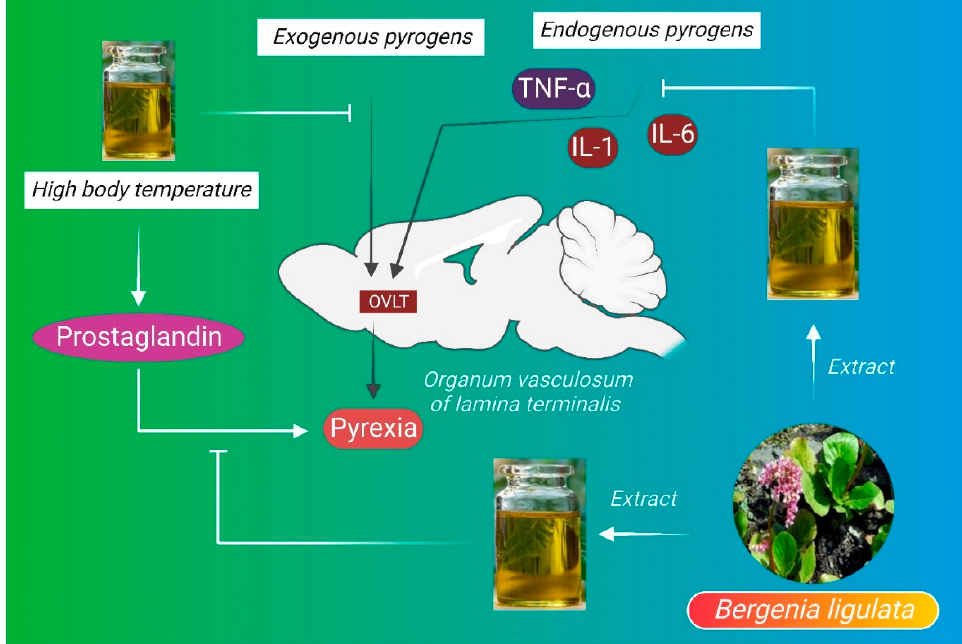
Figure 4. Antipyretic mechanism of B. ligulata . The biomolecules present in B. ligulata have been suggested to block the activity of pyrogens on temperature-sensitive neurons in the preoptic area of hypothalamus, thereby ameliorating fever. IL-1—interleukin-1, IL-6—interleukin-6, OVLT—organum vasculosum laminae terminalis.